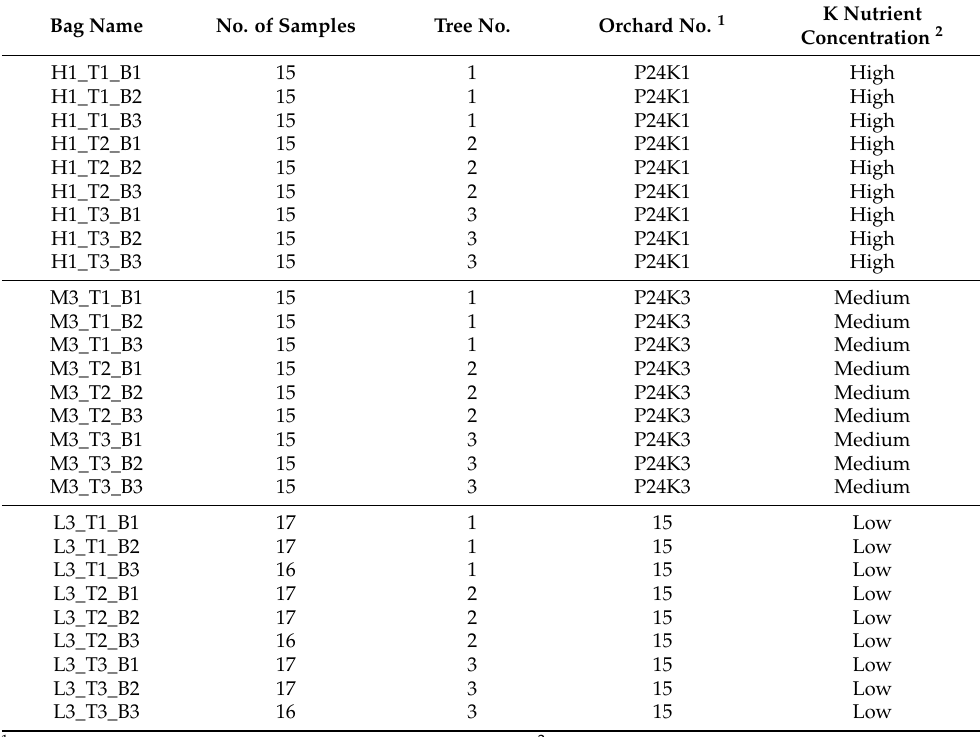
Figure 1. Leaf sample collection for the three levels of K nutrients. Table 1. Complete description of all treatments in the experiment.